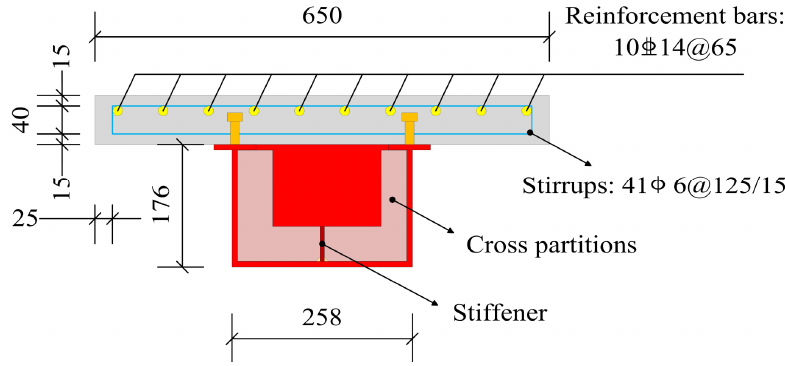
Figure 2. Cross section of specimen. Table 1. Details of the specimens.